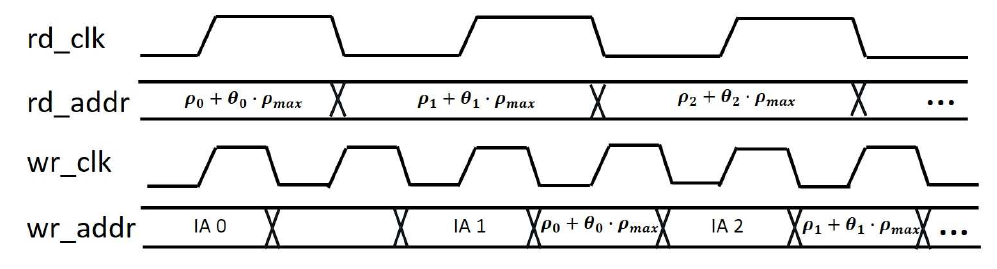
Figure 5. Dual-clock scheme with dual-write processing